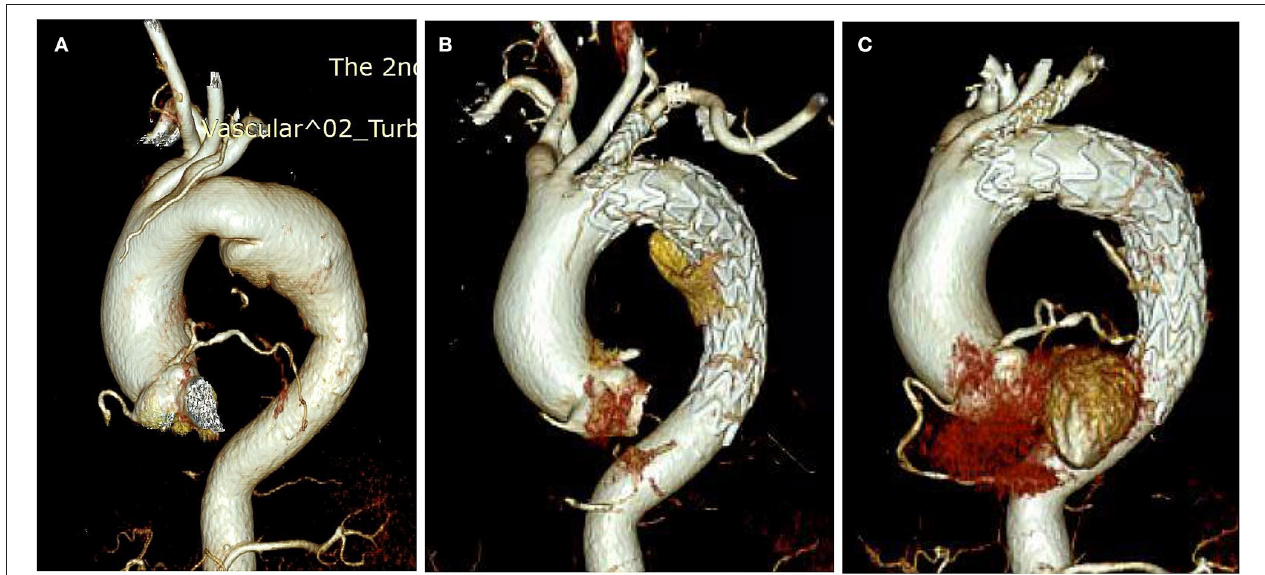
FIGURE 4 | The CTA of the aorta before and after the TEVAR. (A) Before TEVAR; (B) 1-week CTA check after TEVAR; (C) 6 months CTA check after